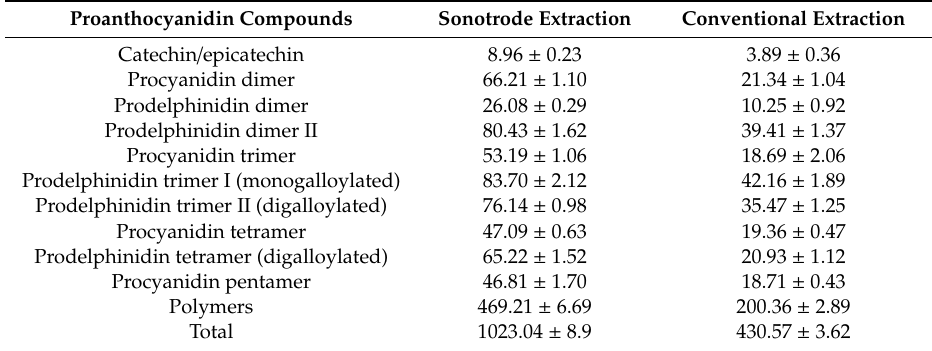
Table 6. Comparison of proanthocyanidin content using sonotrode and conventional extractions ( µ g / g